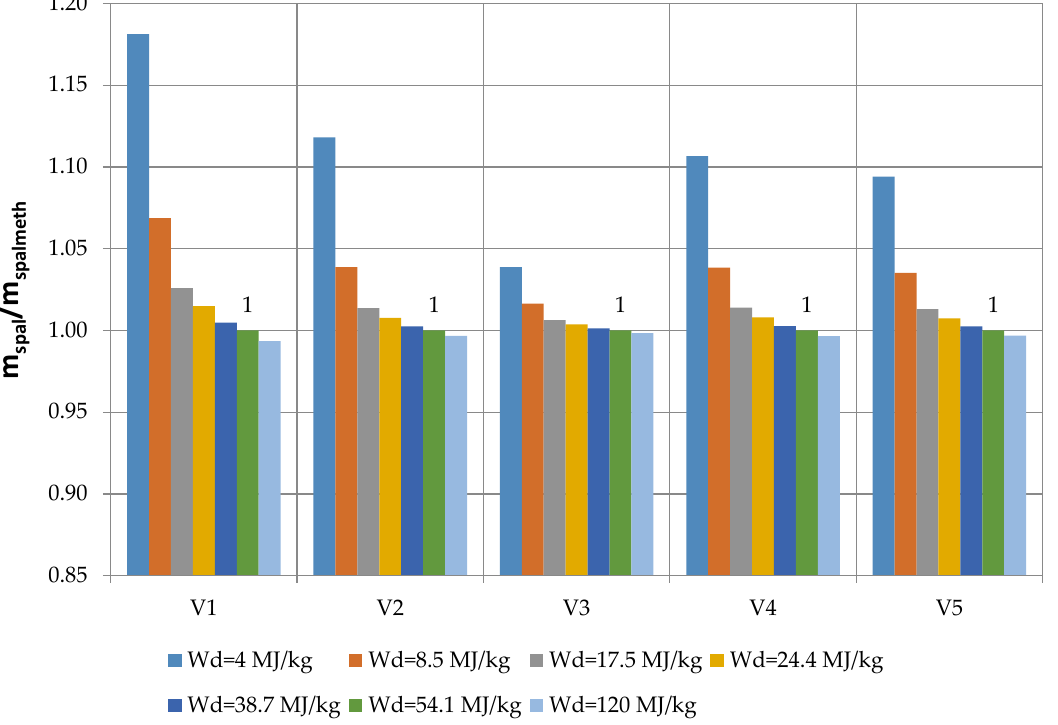
Figure 14. Collective diagram of the influence of the structure of the cycle and the calorific value of fuel on the exhaust gas mass flux as compared to the variants of the cycles with methane.